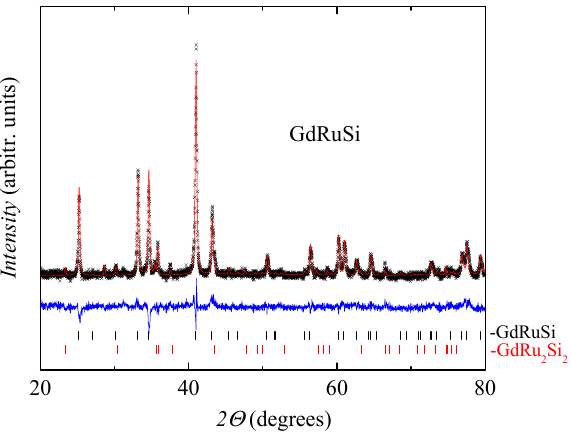
Figure 1. X-ray diffraction pattern (symbols) and its fitting (envelop line) of GdRuSi. The lower curve is the difference between the experimental and calculated results. Vertical lines show the reflection positions for the (up-down) GdRuSi and GdRu 2 Si 2 compounds.